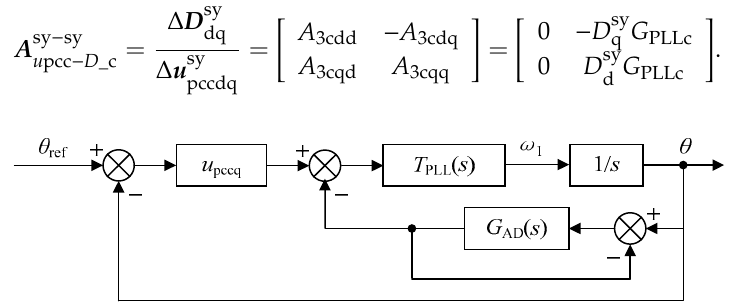
Figure 11. The Bode diagrams of inverter output admittances Y invc_PLL with proposed admittance reshaping technique 1. ( a ) Y cdd ; ( b ) Y cqd ; ( c ) Y cdq ; ( d ) Y cqq .